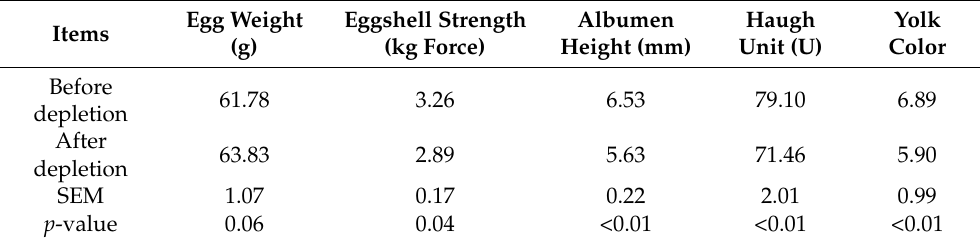
Table 5. Egg quality of aged laying hens fed selenium-deficient diets over